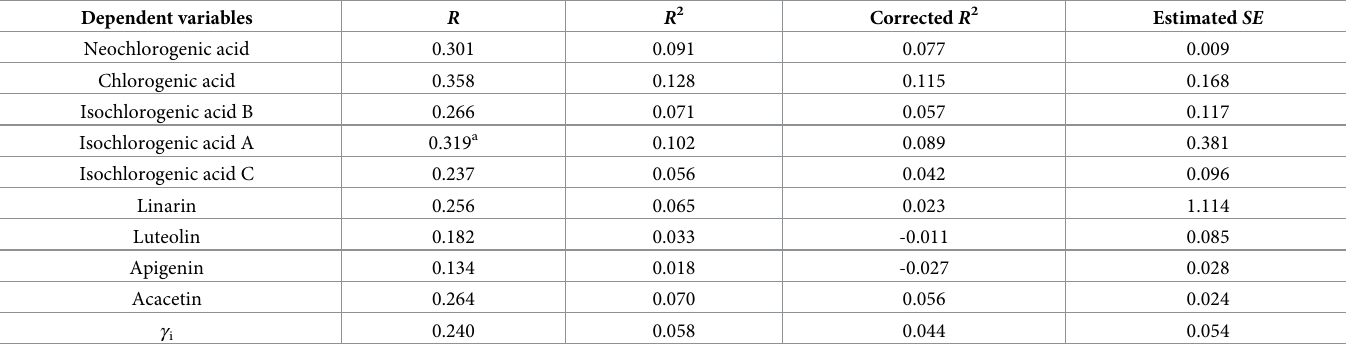
Table 6. Multiple regression analysis on the constituents, γ i , and color parameters of